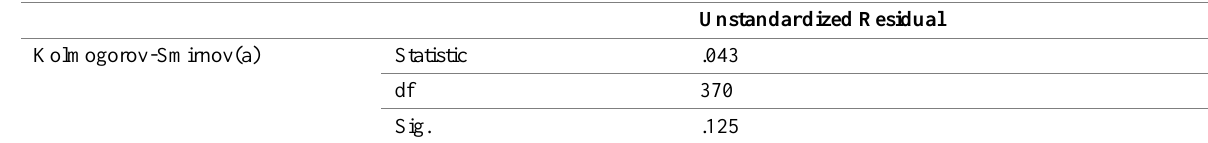
Table 4: Normality Test Results